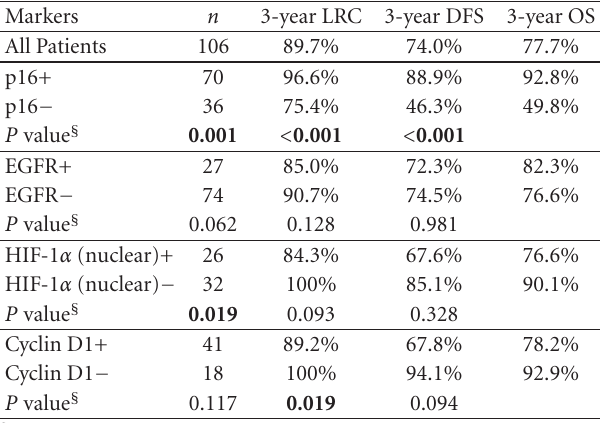
Table 5: Summary of survival results stratified by biomarker status.